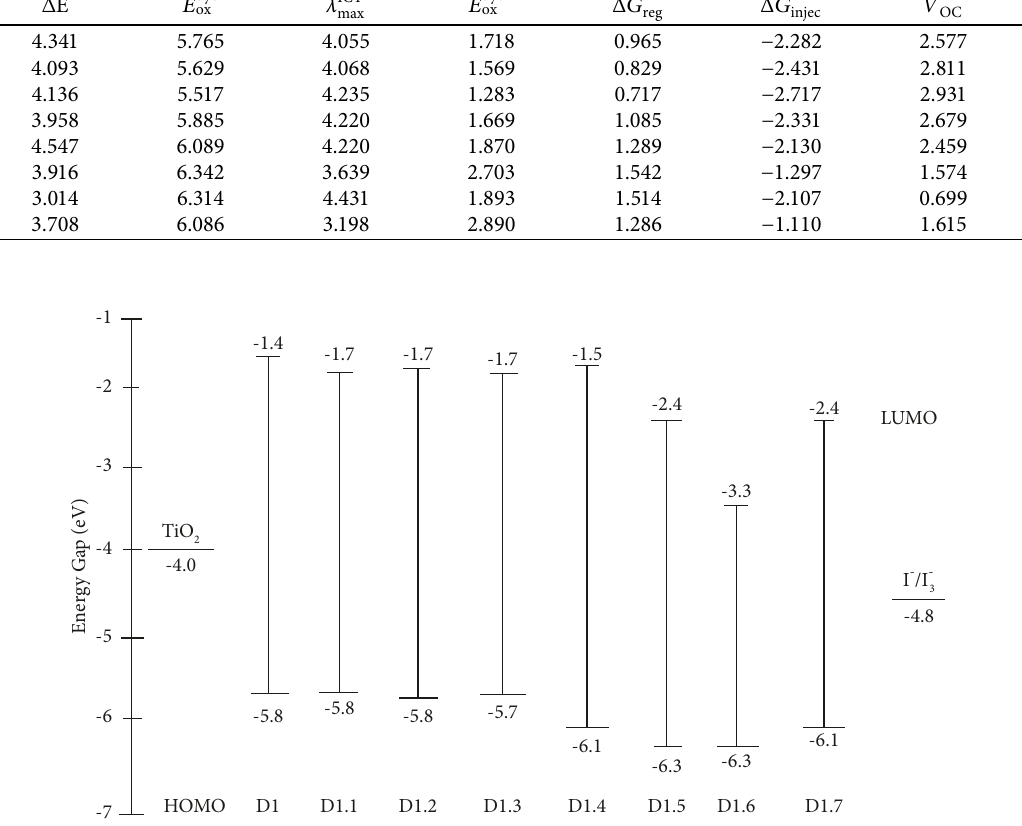
Table 5: The calculated band gap ( ∆ E), ground ( E dye force for dye regeneration ( ∆ G reg ), electron injection efficiency ( ∆ G inject ), open circuit photovoltage (V OC ), and binding energy (E b ) of the